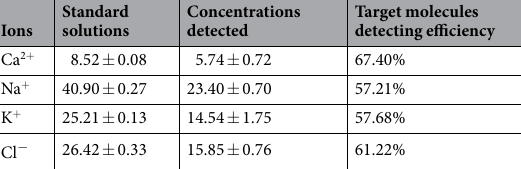
Table 1. Target molecules detecting efficiency of the probe (mmol/L).